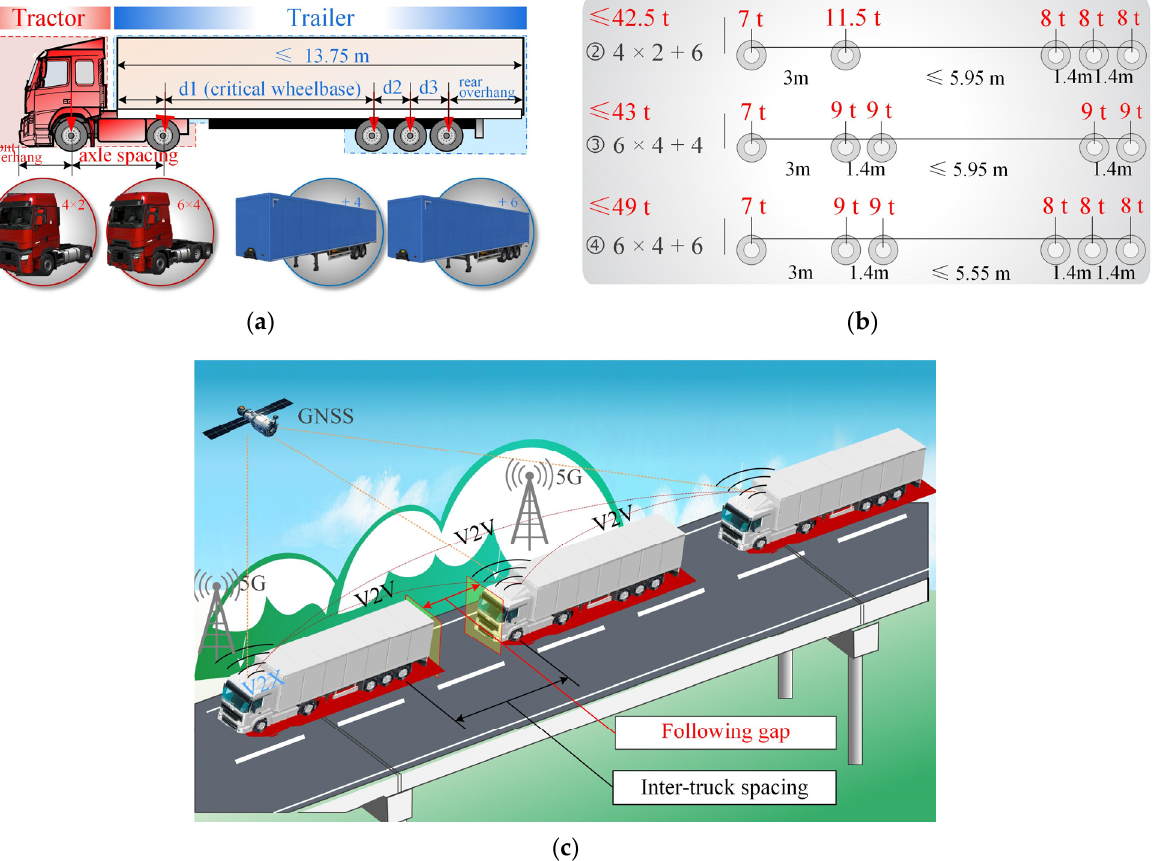
Figure 3. Truck platoon loads: ( a ) components of a semi-trailer truck; ( b ) dimensions, axle loads, and masses of three typical semi-trailer trucks; ( c ) schematic of an ATP crossing a highway bridge.